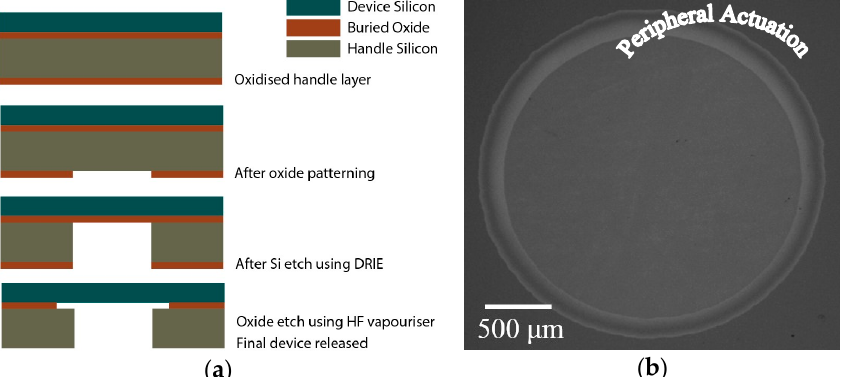
Figure 1. The figure ( a ) shows the fabrication steps to obtain the MEMS speaker using only a SOI wafer, and ( b ) shows the optical image of the MEMS speaker fabricated using a single SOI wafer.